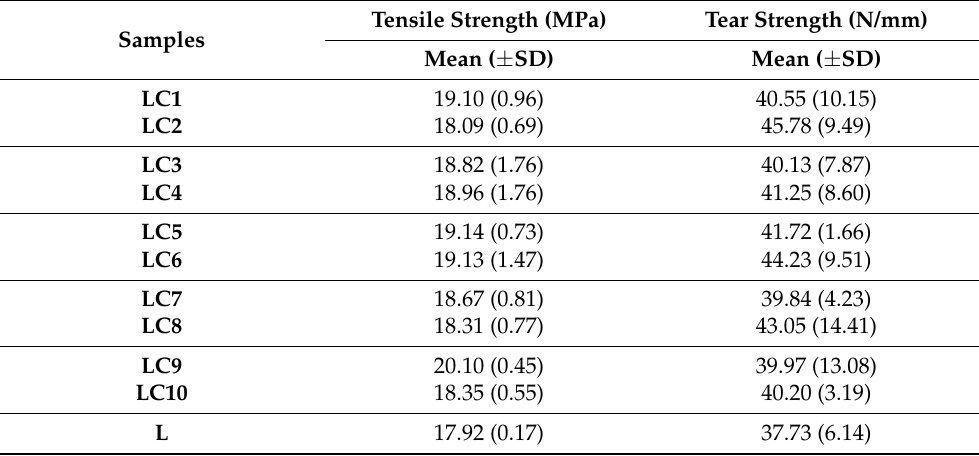
Table 2. Mechanical properties of LC films before